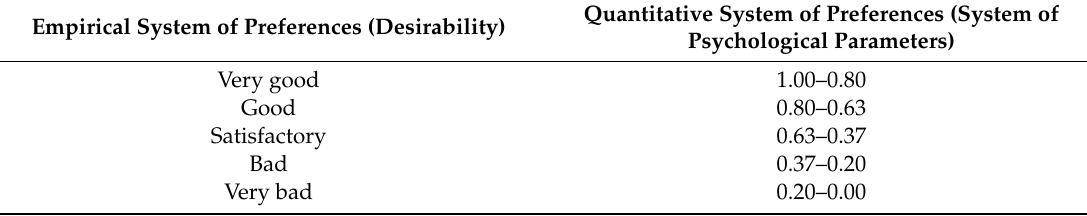
Table 3. Harrington’s desirability scale.